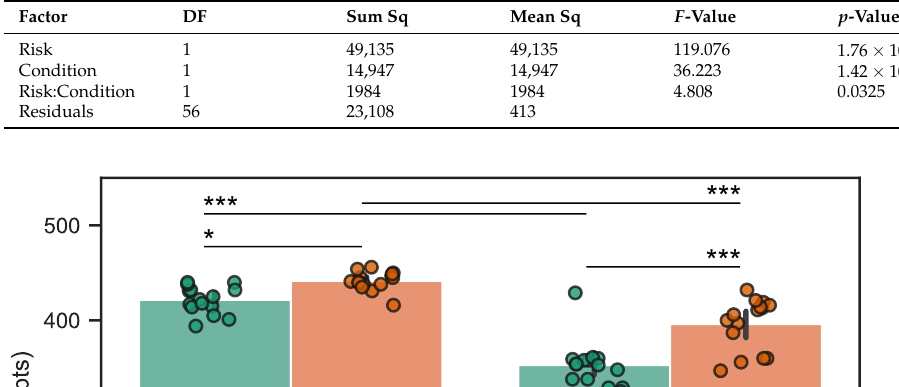
Table 2. The summary table for ANOVA results for the total score. DF is degrees of freedom, Sum Sq contains values for the sum of squares, Mean Sq are mean squares, and F - and p -values are respective ANOVA statistics values.